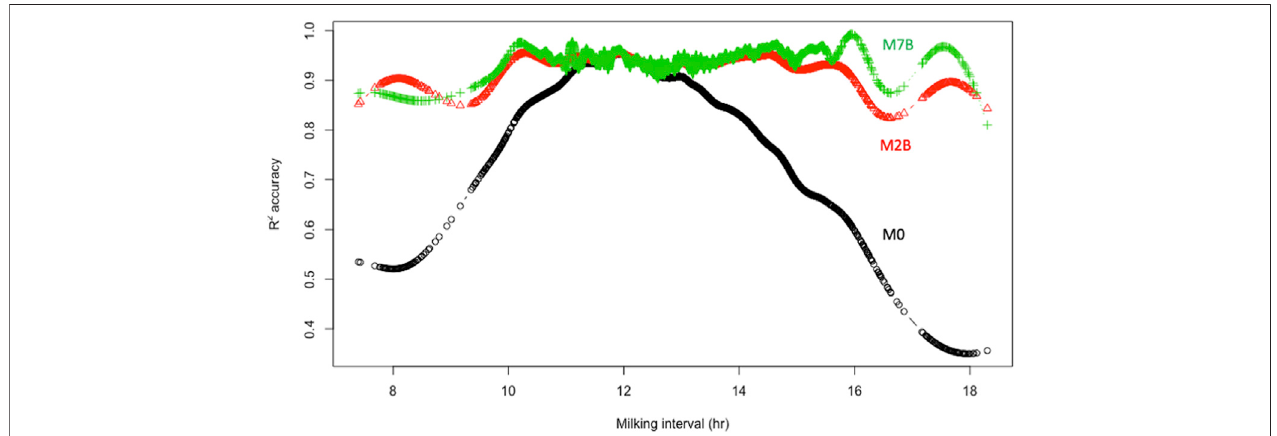
FIGURE 4 | Relationships between smooth splines means of individual R 2 accuracies of the estimated daily milk yield and milking interval for three models, M0, M2B, and M7B. M0 = two times AM or PM yield as the estimate of test-day milk yield; M2B = additive correction factor model implemented by regressing the difference between AM and PM yields on milking interval and days in milk; M7B = multiplicative correction factor model according to Wiggans (1986).